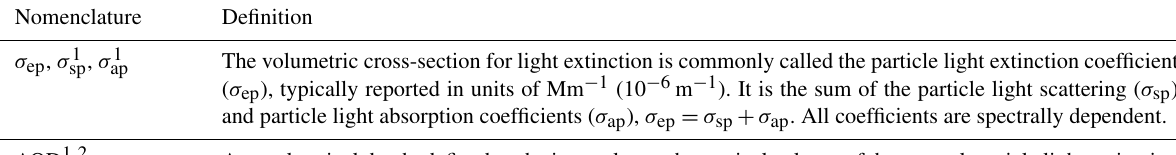
Table 1. Measured and derived aerosol particle properties relevant to radiative forcing on climate (adapted from GAW Report No.